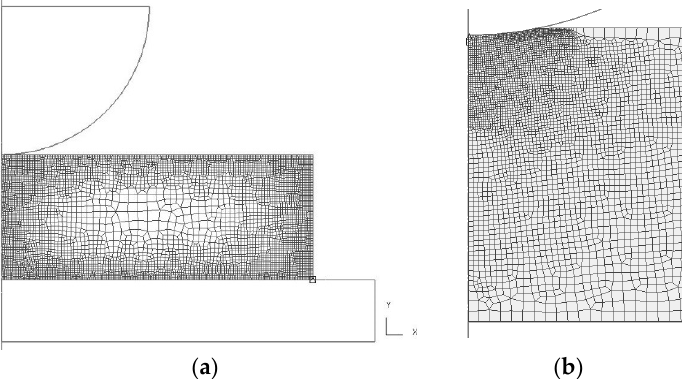
Figure 2. ( a ) Geometric set ‐ up used for the simulation of Brinell hardness; and ( b ) fine mesh ele ‐ ments in the vicinity of an indent.